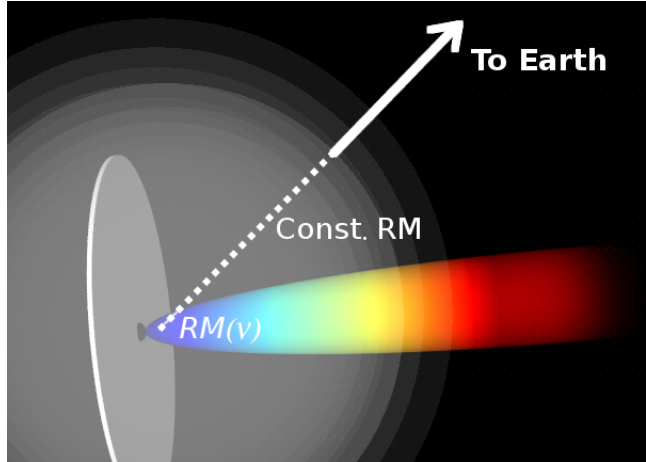
Figure 2. Sketch of the jet morphology close to the base of the outflow (not in scale). Only emission at high frequencies (blue) can escape from the jet base. The rotation measure (RM) from these regions can either be internal to the jet or from a shear around it, or be induced by a screen of infalling material. In the former case, RM would depend on frequency, RM ( ν ) ; in the latter, it would rather be constant in the submm spectral